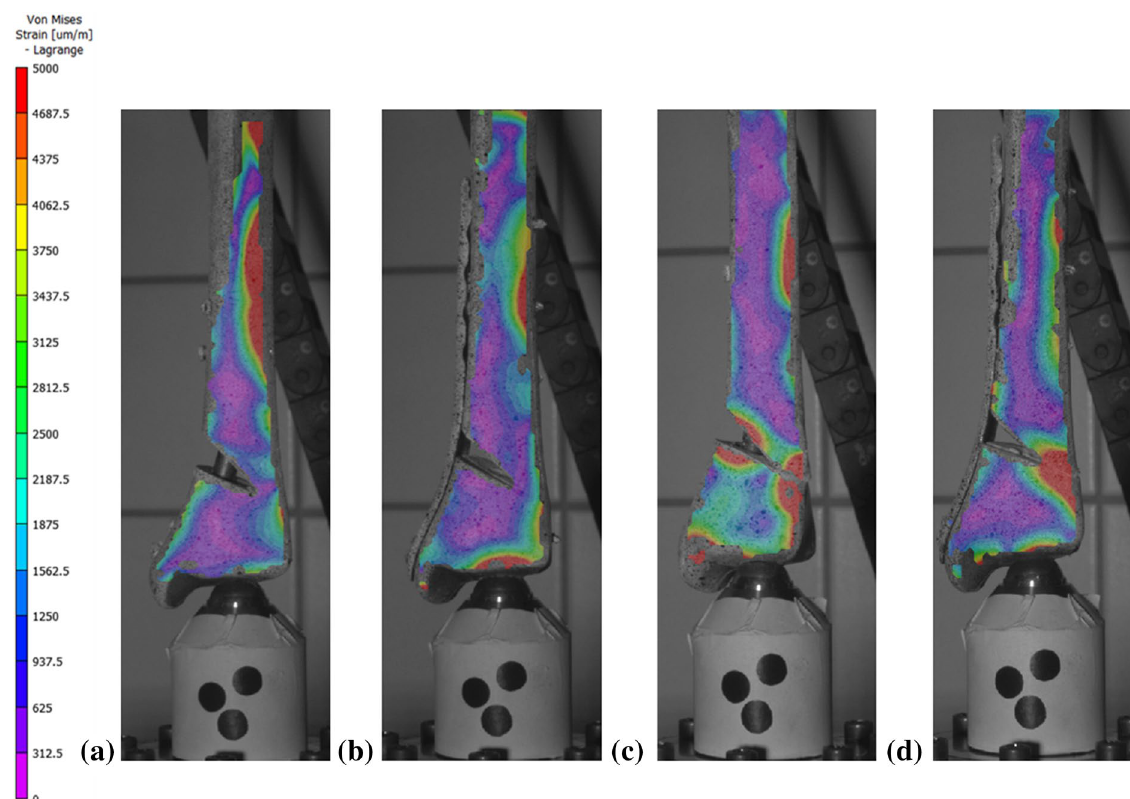
Figure 6. Von Mises’ strain (micro-strain) distribution for DTN ( a , c ) and MDTP ( b , d ) samples of similar stiffness in the best ( a , b ) and worst ( c , d )-case surgical scenario; red/warm colours indicate high Von Mises’ strain, blue/cold colours indicate low Von Mises’ strain. Images correspond to samples DTN-3 ( a ), MDTP-4 ( b ), DTN-8 ( c ), MDTP-5 ( d ). Image obtained used Vic3D software (version 8), https:// www. corre lated solut ions. com/ vic-